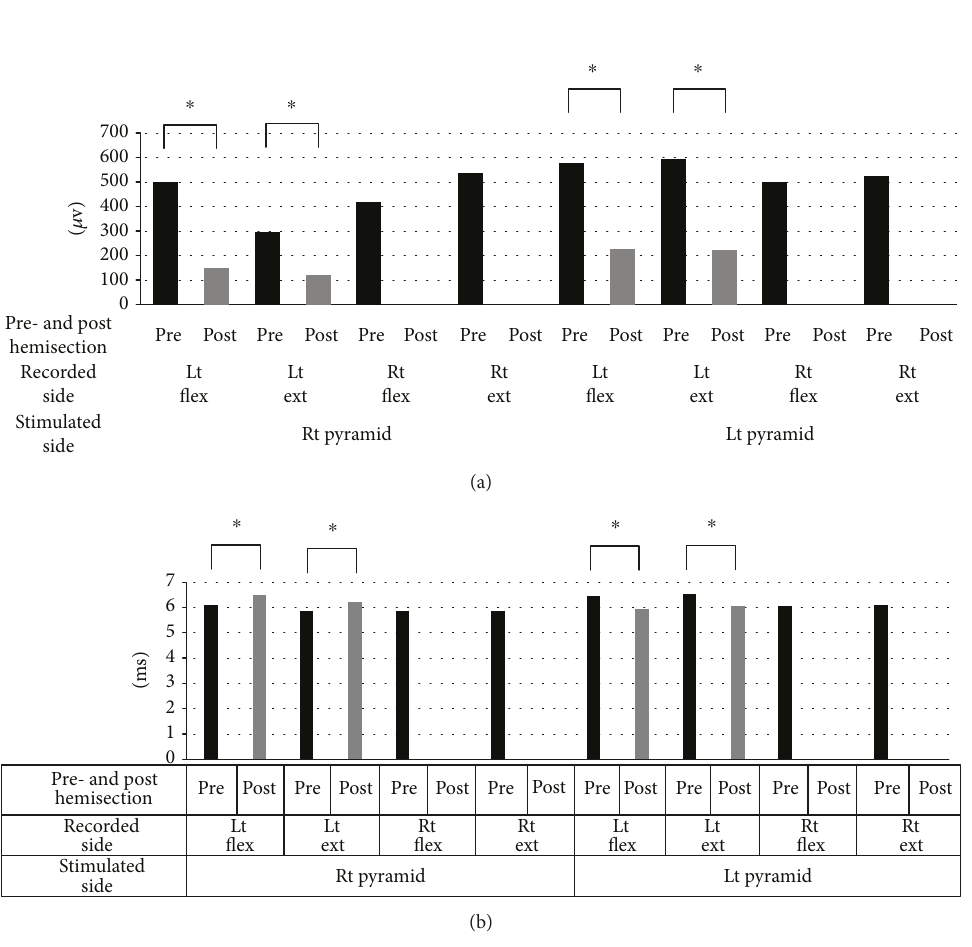
Figure 9: Amplitude (a) and latency (b) of CMAPs before and after the additional C2 hemisection performed on the C2 rat group. (a) In response to the stimulation of both the left and right pyramids, CMAPs of the right forelimb were lost after the additional right C2 hemisection, whereas the amplitude of CMAPs of the left forelimb was not lost although it decreased signi fi cantly ( ∗ p < 0 05 ). (b) Signi fi cant extension of the latency was found in the record of the left forelimb in response to the stimulation of the right pyramid, whereas a signi fi cant shortening of latency was found in the record of the left forelimb in response to the stimulation of the left pyramid ( ∗ p < 0 05 ). CMAPs: compound muscle action potentials; Rt: right; Lt: left; Flex: fl exor; Ext: